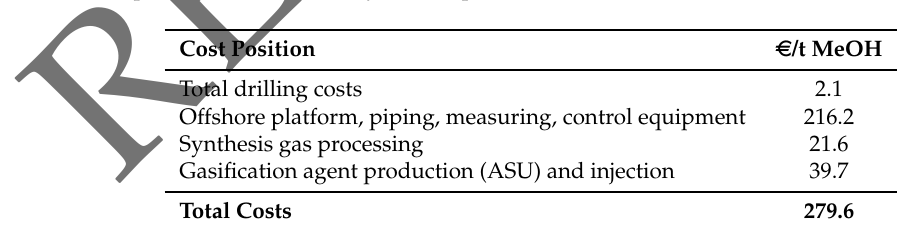
Table 13. Individual components of levelized offshore Underground Coal Gasification (UCG) based methanol production costs for 20 years of